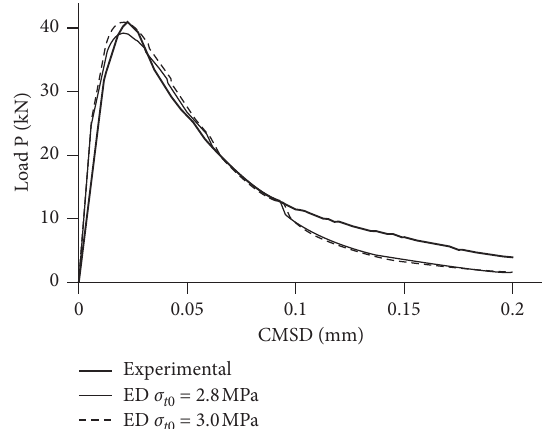
Figure 17: Load versus CMSD for the four-point